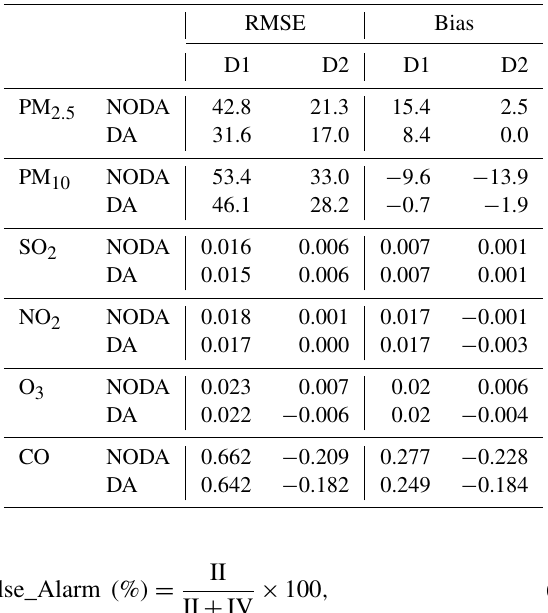
Table 3. The RMSE and bias errors of 24h forecasts in NODA and DA experiments.